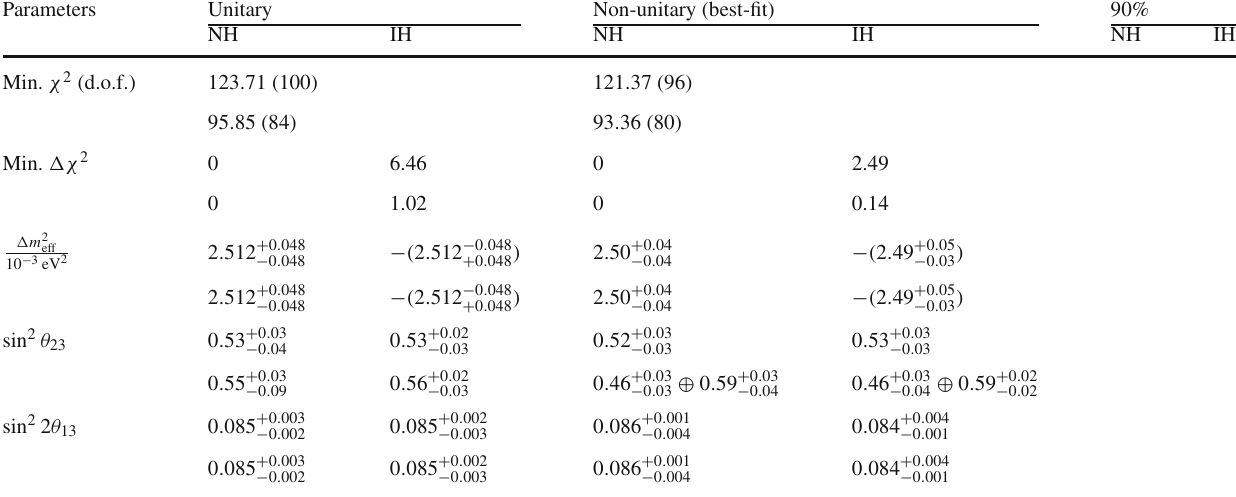
Table 2 Parameter values at the best-fit points for T2K.The 1 σ error bars have been mentioned where possible. The 90% limits for 1 d.o.f have also been mentioned. In each box, the result with 2019 (2020) data has been mentioned at the top (bottom) of the box Parameters